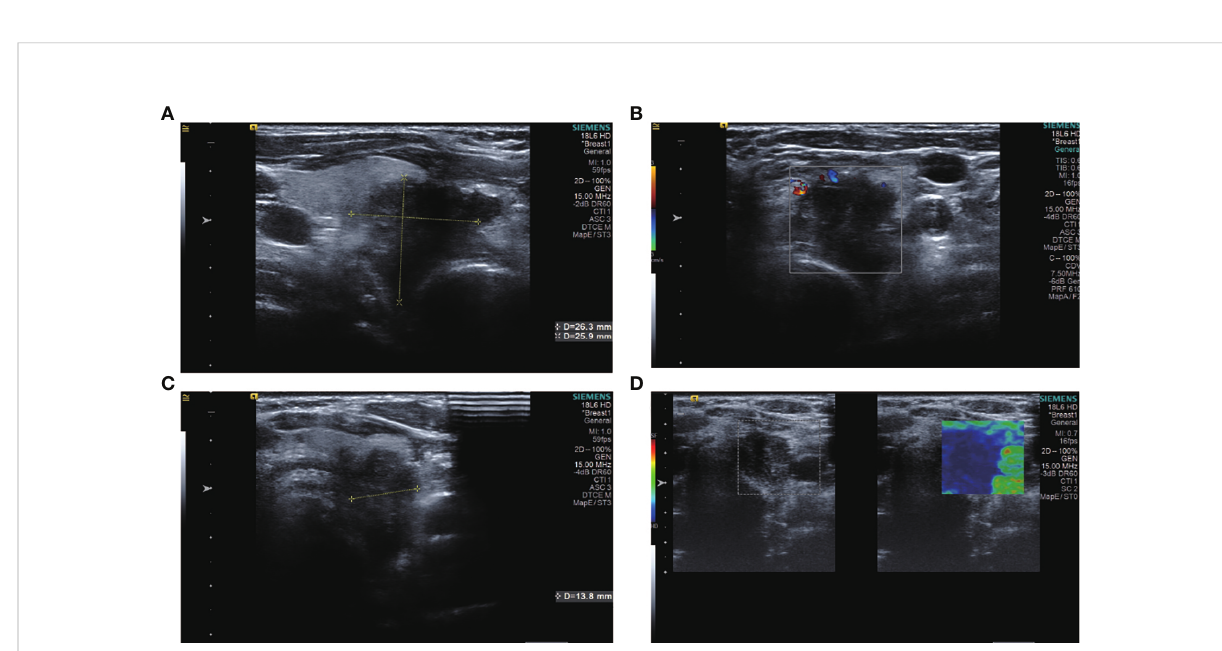
FIGURE 2 ultrasound images of patient #2, showing a hypoechoic nodule with indistinct borders in the left lobe of the thyroid gland, which was clearly visible as a nodule breaking through the thyroid peritoneum and invading the surrounding tissue. The patient underwent surgery only and had a survival period of 2 years and 7 months. (A) Sagittal scan (B) CDFI (C) Transverse scan (D)